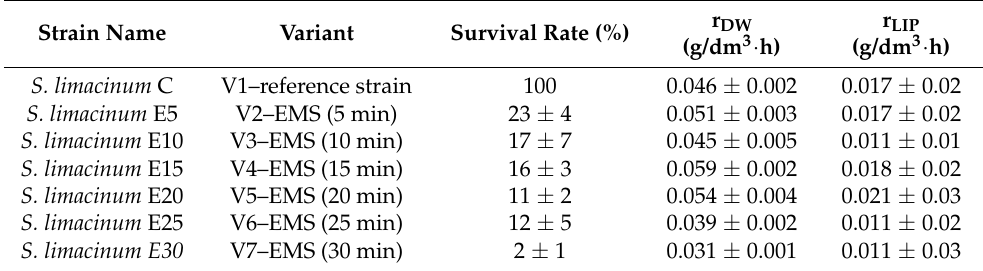
Table 5. S. limacinum survival, biomass growth, and lipid accumulation rates vs EMS exposure